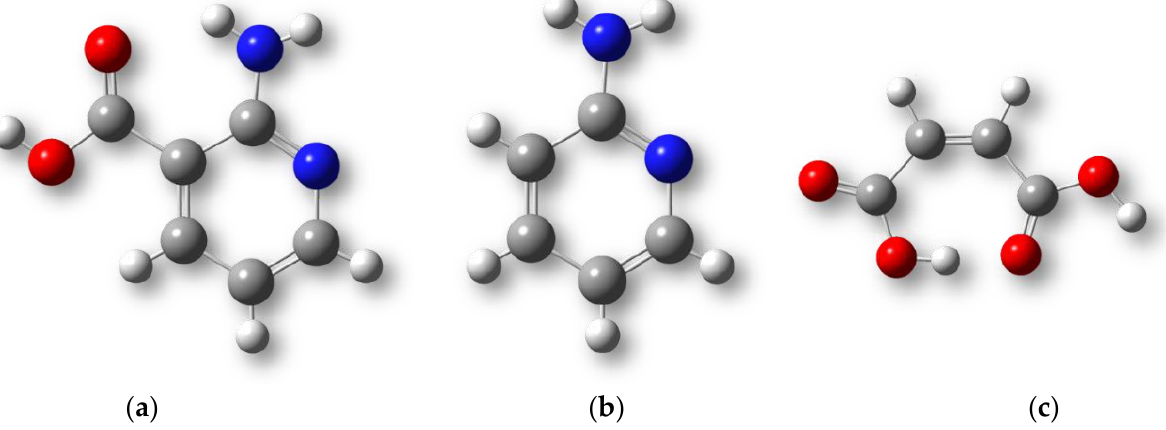
Scheme 1. Structures of 2-aminopyridine ( a ), 2-aminonicotinic acid ( b ), and maleic acid ( c ). The red, blue, gray and white circles represent oxygen, nitrogen, carbon, and hydrogen atoms, respectively.